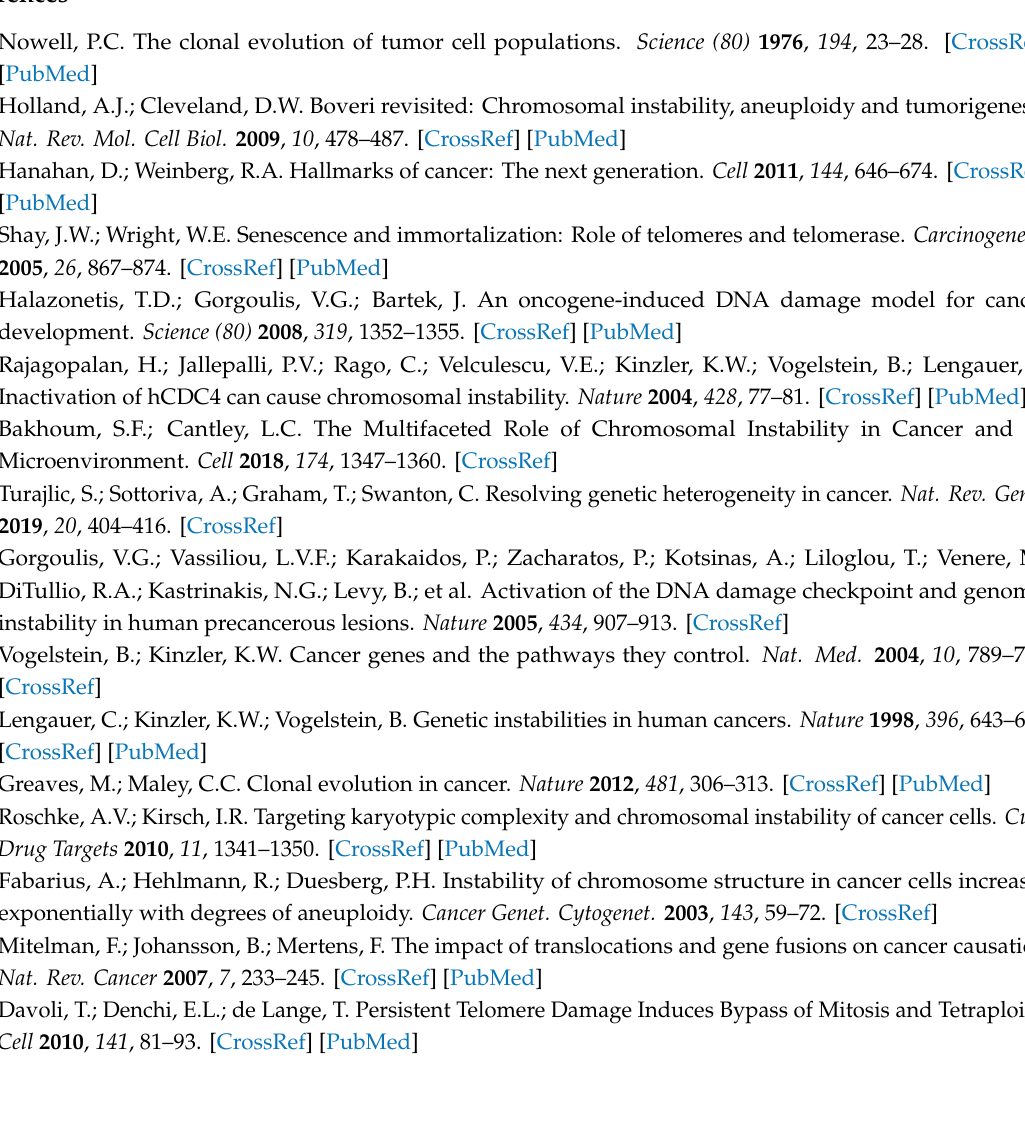
Figure S12: Random chromosome rearrangements in irradiated VA-13 cells: WGD subclones. Figure S13: Random chromosome rearrangements in control Saos2 cells. Figure S14: Random chromosome rearrangements in survivors of p21 overexpression. Figure S15: Chromosome numbers in 50 VA-13 cells after